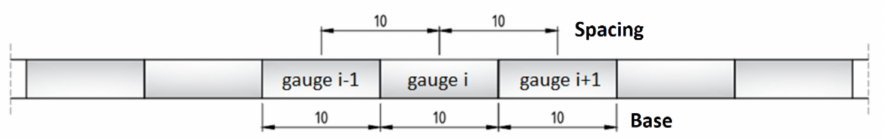
Figure 7. Parameters of distributed fibre optic strain measurements (both gauge’s spacing and measuring base set to 10 mm as an example)